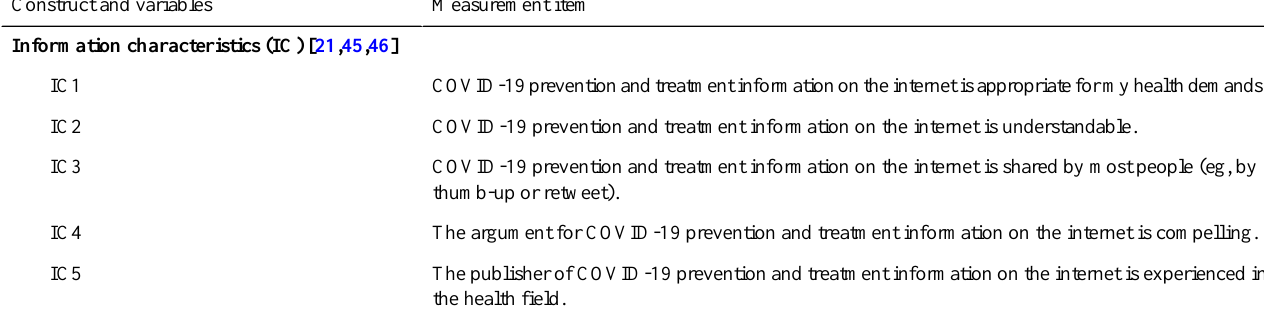
Measurement itemConstruct and